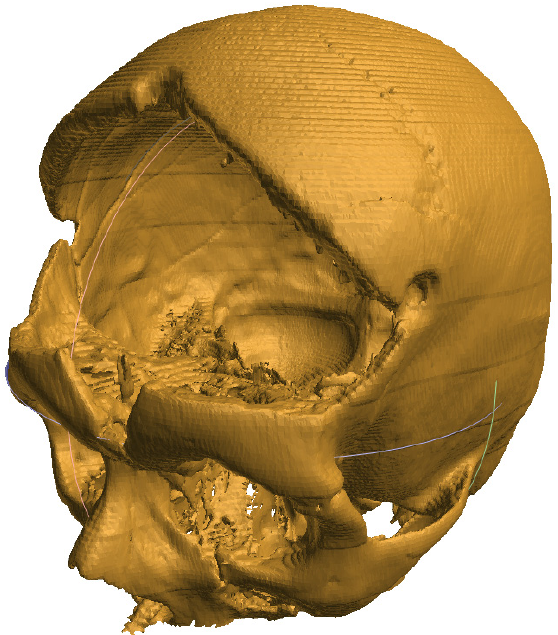
Figure 3. Image of a skull after removal of damaged bone following an accident, obtained by processing a set of tomography images.